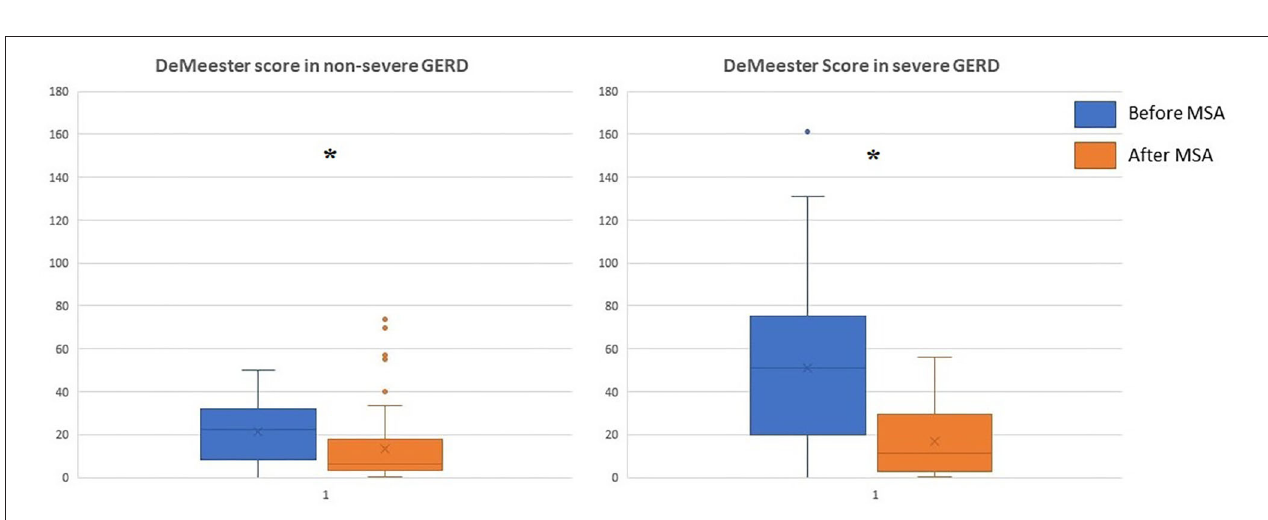
FIGURE 5 | DeMeester score in patients with severe or non severe GERD before and after MSA procedure. MSA, magnetic sphincter augmentation; GERD, gastro-esophageal reflux disease; * p < 0.05.